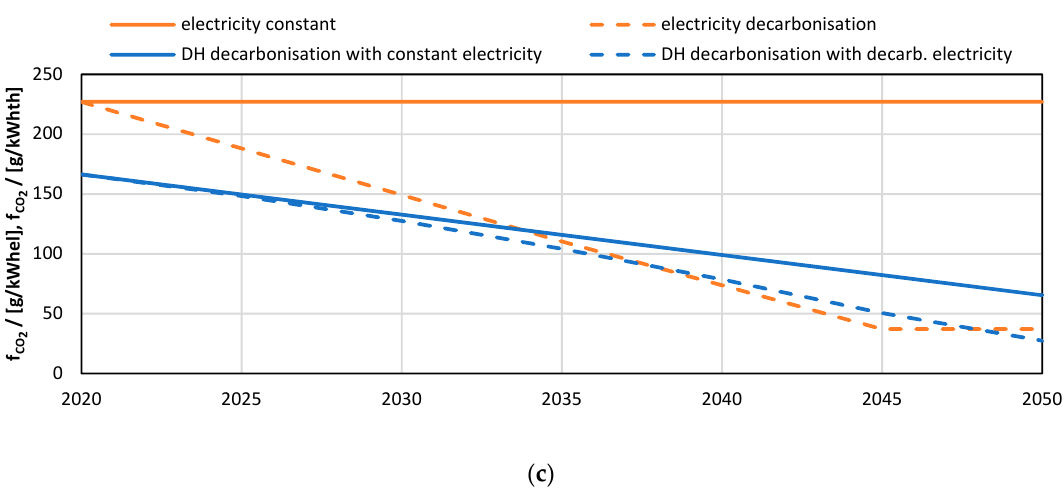
Figure 19. ( a ) Possible phase-out scenario in the electricity system with an increasing share of Wind and PV, ( b ) possible phase-out scenario in DH with an increasing share of HPs and ( c ) resulting CO 2 conversion factors for electricity and DH.